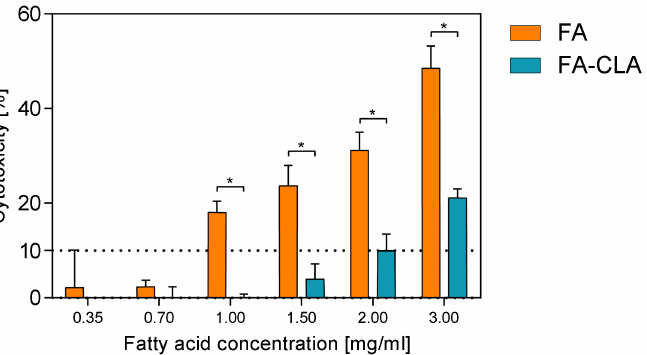
Figure 1. Effect of a mixture of fatty acids extracted from CLA-enriched and non-enriched yolks on cytotoxicity of human cancer cells line WM793. The Mann–Whitney U test was used for statistical analysis, *—statistically significant differences between FA-CLA and FA samples, at a significance level of p ≤ 0.05. The results are presented as mean, ± SD for n =